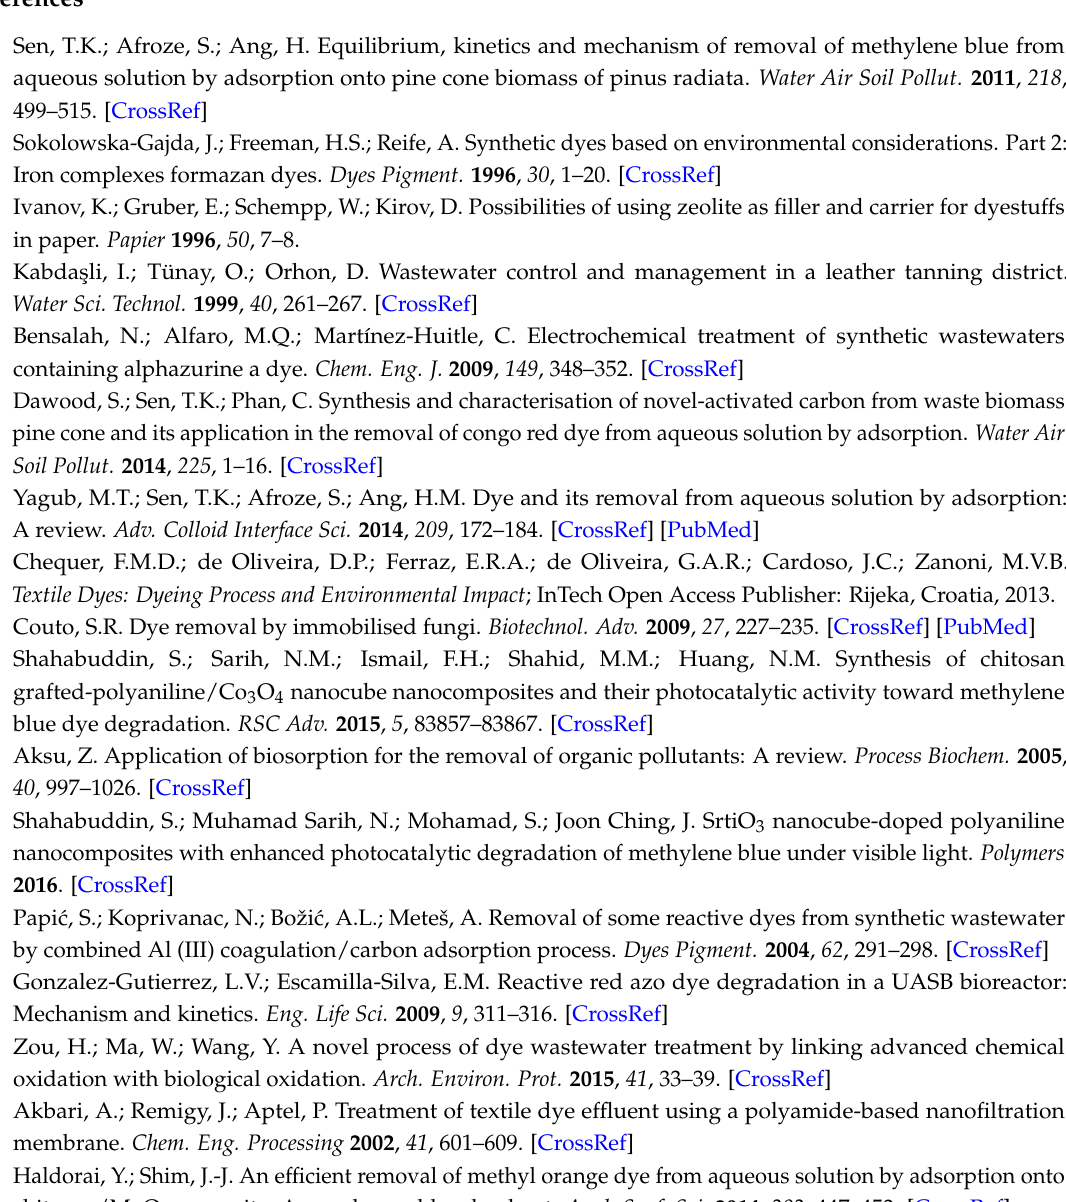
Figure S4: FESEM image of GOPSr-2 nanocomposite after fifth reusability